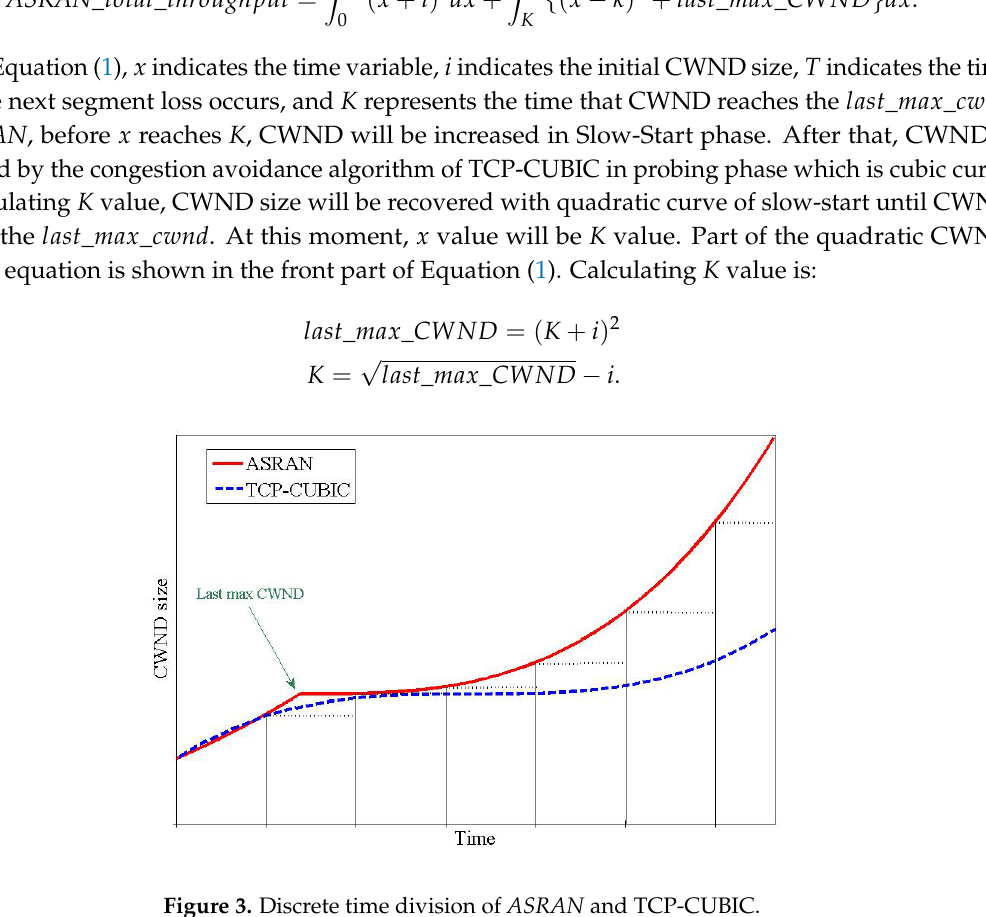
Figure 3. Discrete time division of ASRAN and